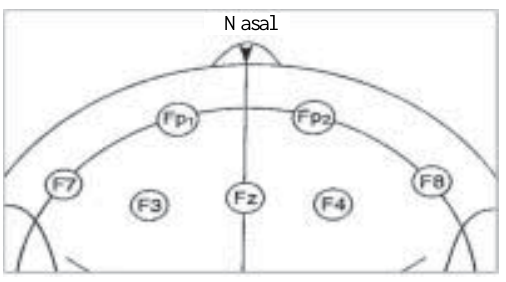
Fig. 1 – International system of the placing of the electrodes. Nasal: point sited in the middle of the nasofrontal suture. Fp pole. Fp : Right frontal polo. F7 and F3: left frontal points. F4 and 2 F8: right frontal points. Fz: frontal reference.